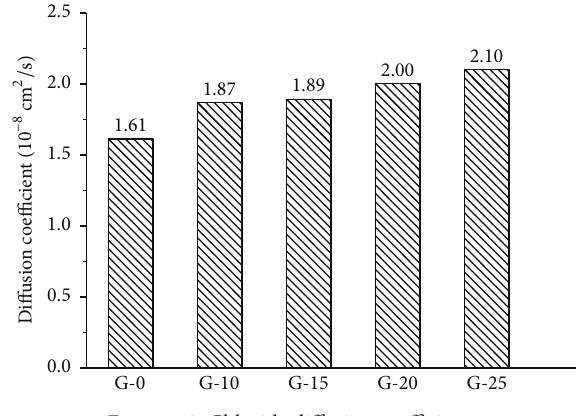
Figure 10: Chloride diffusion